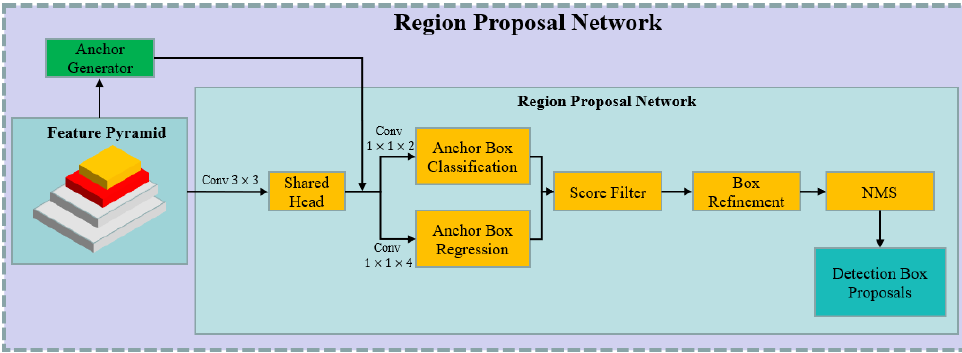
Figure 7. The pipeline of RPN.